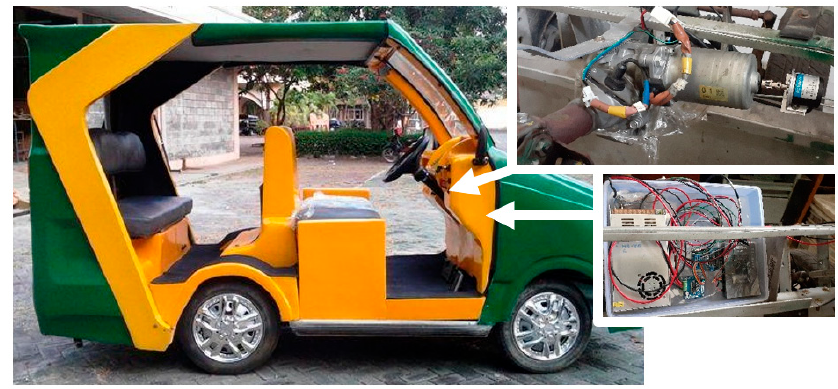
Figure 7. SAAV, EPS motor, and control system. Table 1. Control parameters using Ziegler Nichols method.